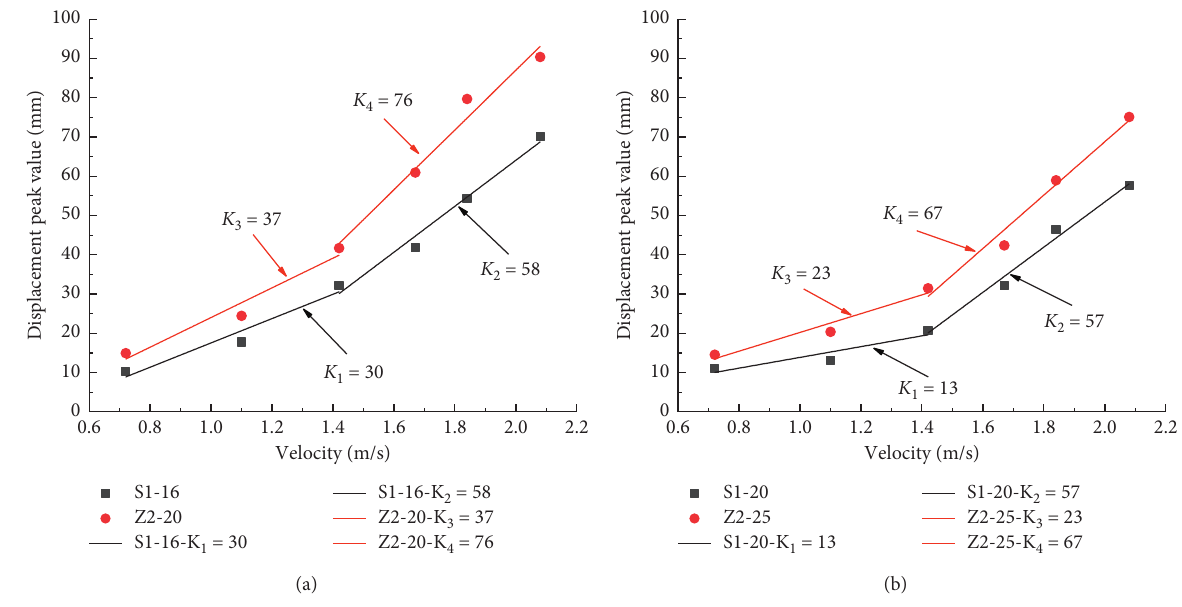
Figure 13: Top peak displacement of the first and second